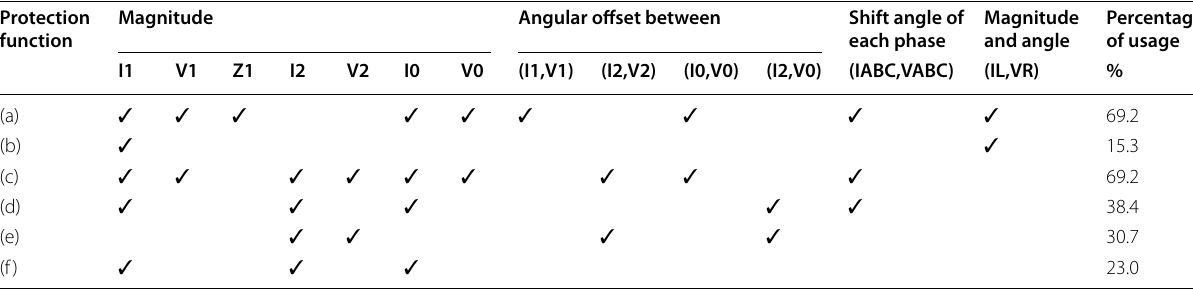
Table 5 Influence of variables on principal functions and element